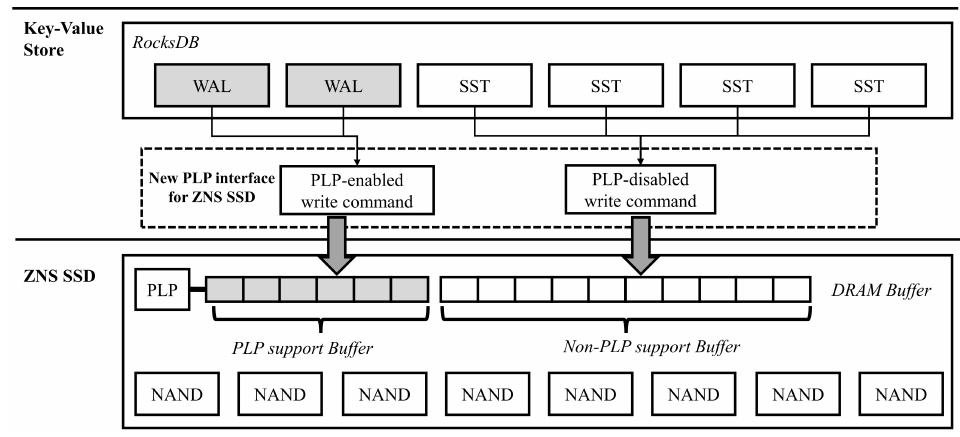
Figure 3. Overview of selective power-loss